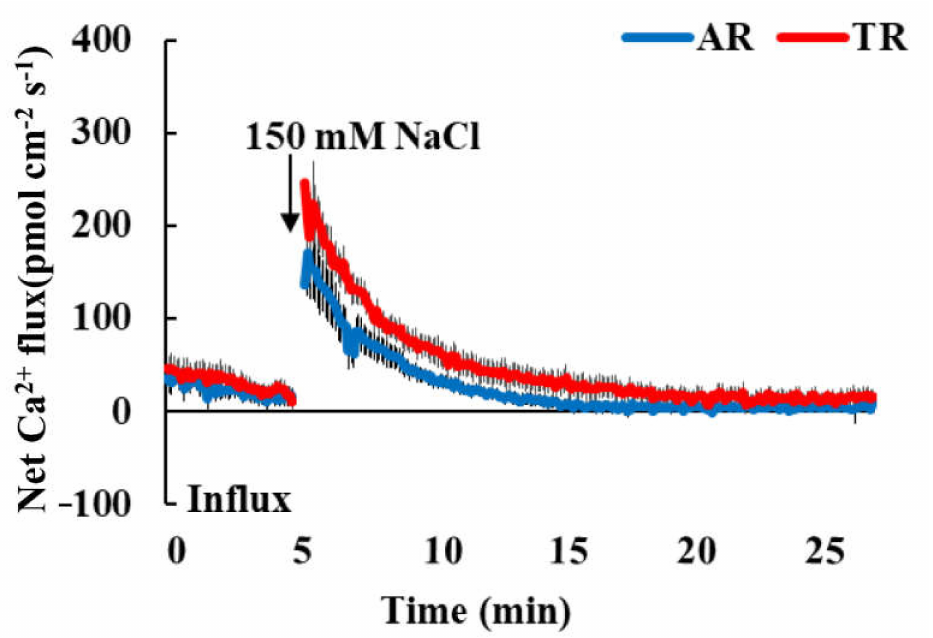
Figure 5. The effect of IbIPUT1 overexpression on the NaCl-induced Ca 2+ kinetics in the elongation zone of sweet potato. Transient kinetics of Ca 2+ flux upon treatment with 150 mM NaCl was measured from the elongation root zone (1 mm from the tip) of TRs and ARs through NMT. n =